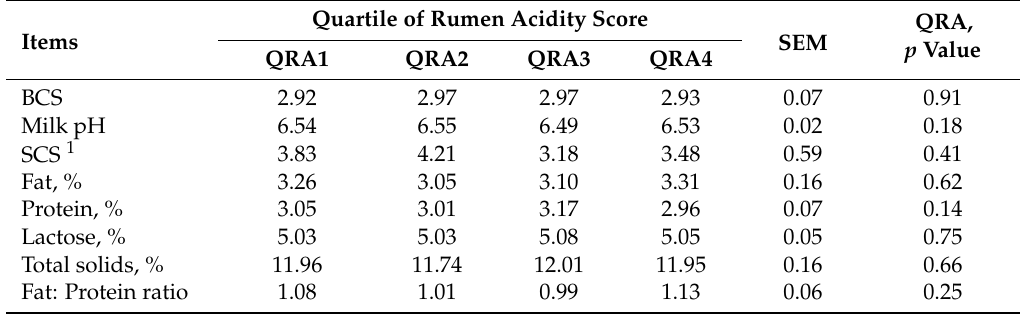
Table 4. Effect of the quartile of rumen acidity score (QRA1, greatest rumen acidity, to QRA4, lowest rumen acidity) on the body condition score (BCS) and milk composition of Holstein cows.